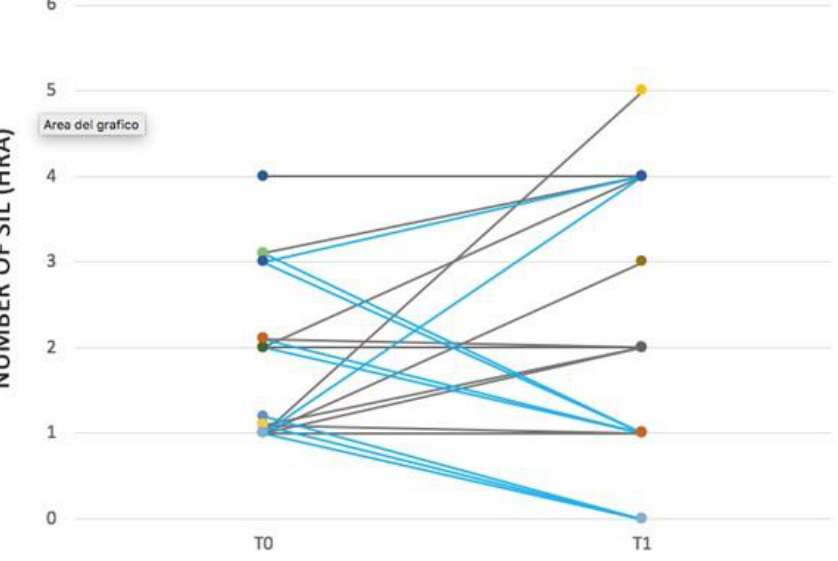
Figure 2. Number of SIL on HRA examination. Blue lines: experimental group. Grey lines: control group.